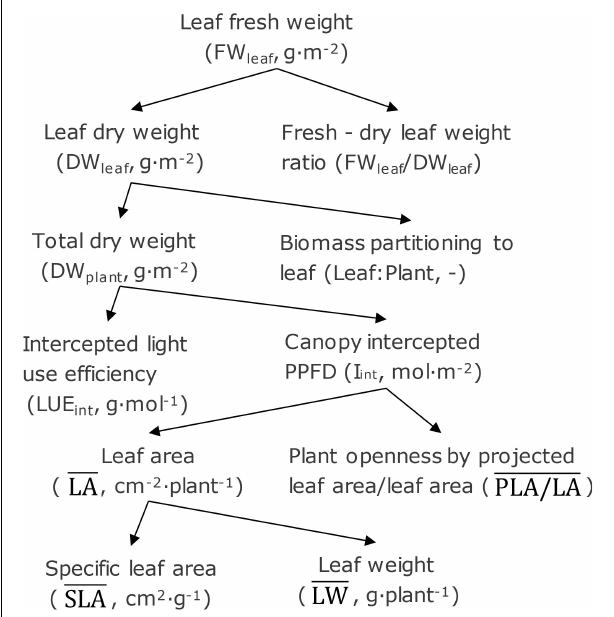
FIGURE 2 | Leaf fresh weight separated into underlying components. Abbreviation and unit are given in between brackets.